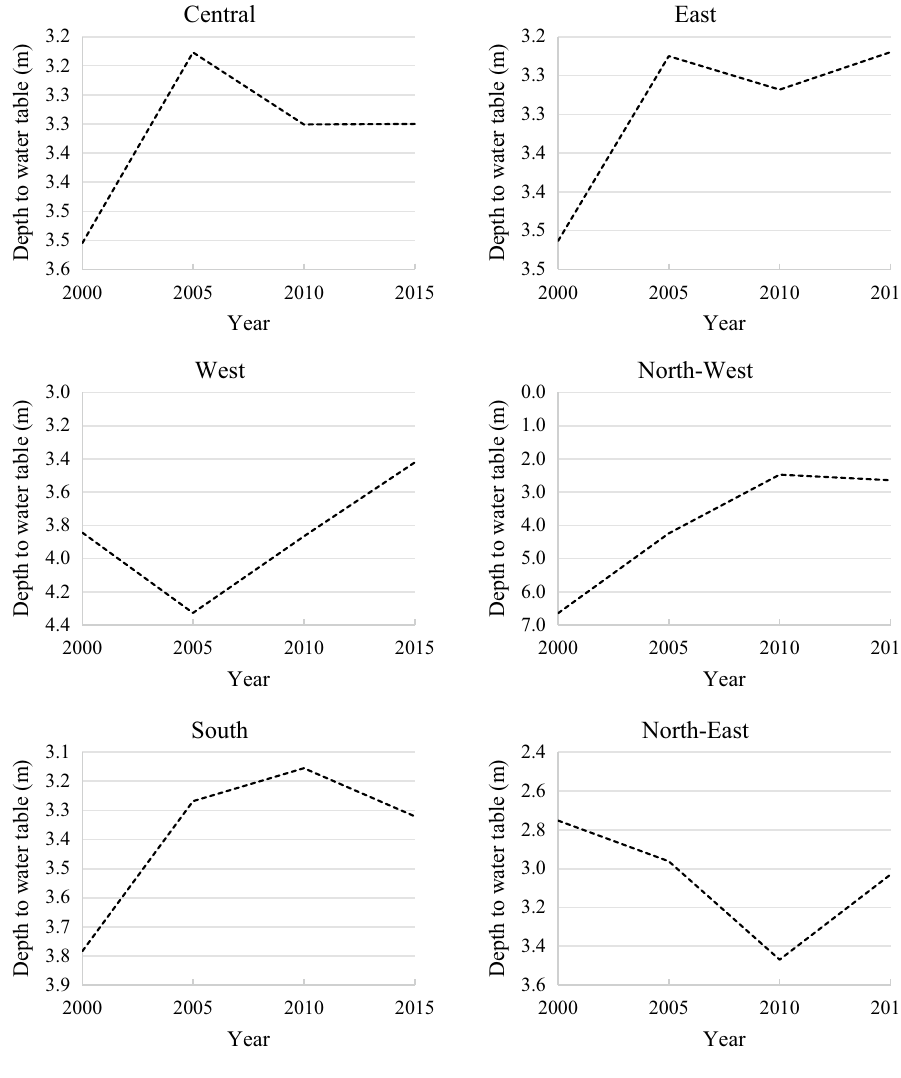
Fig. 6 Temporal plots showing mean annual-average depth to the water tables in the six zones formulated under the